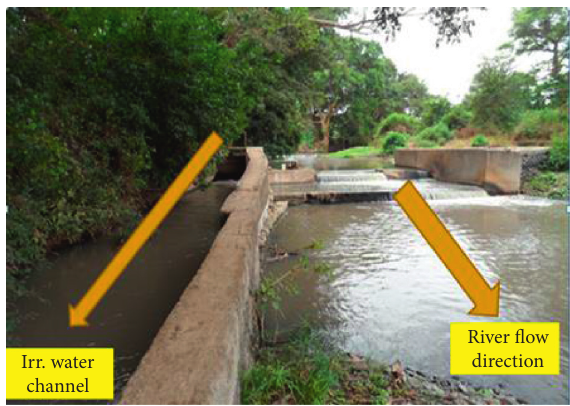
Figure 6: Furrow intake with no river